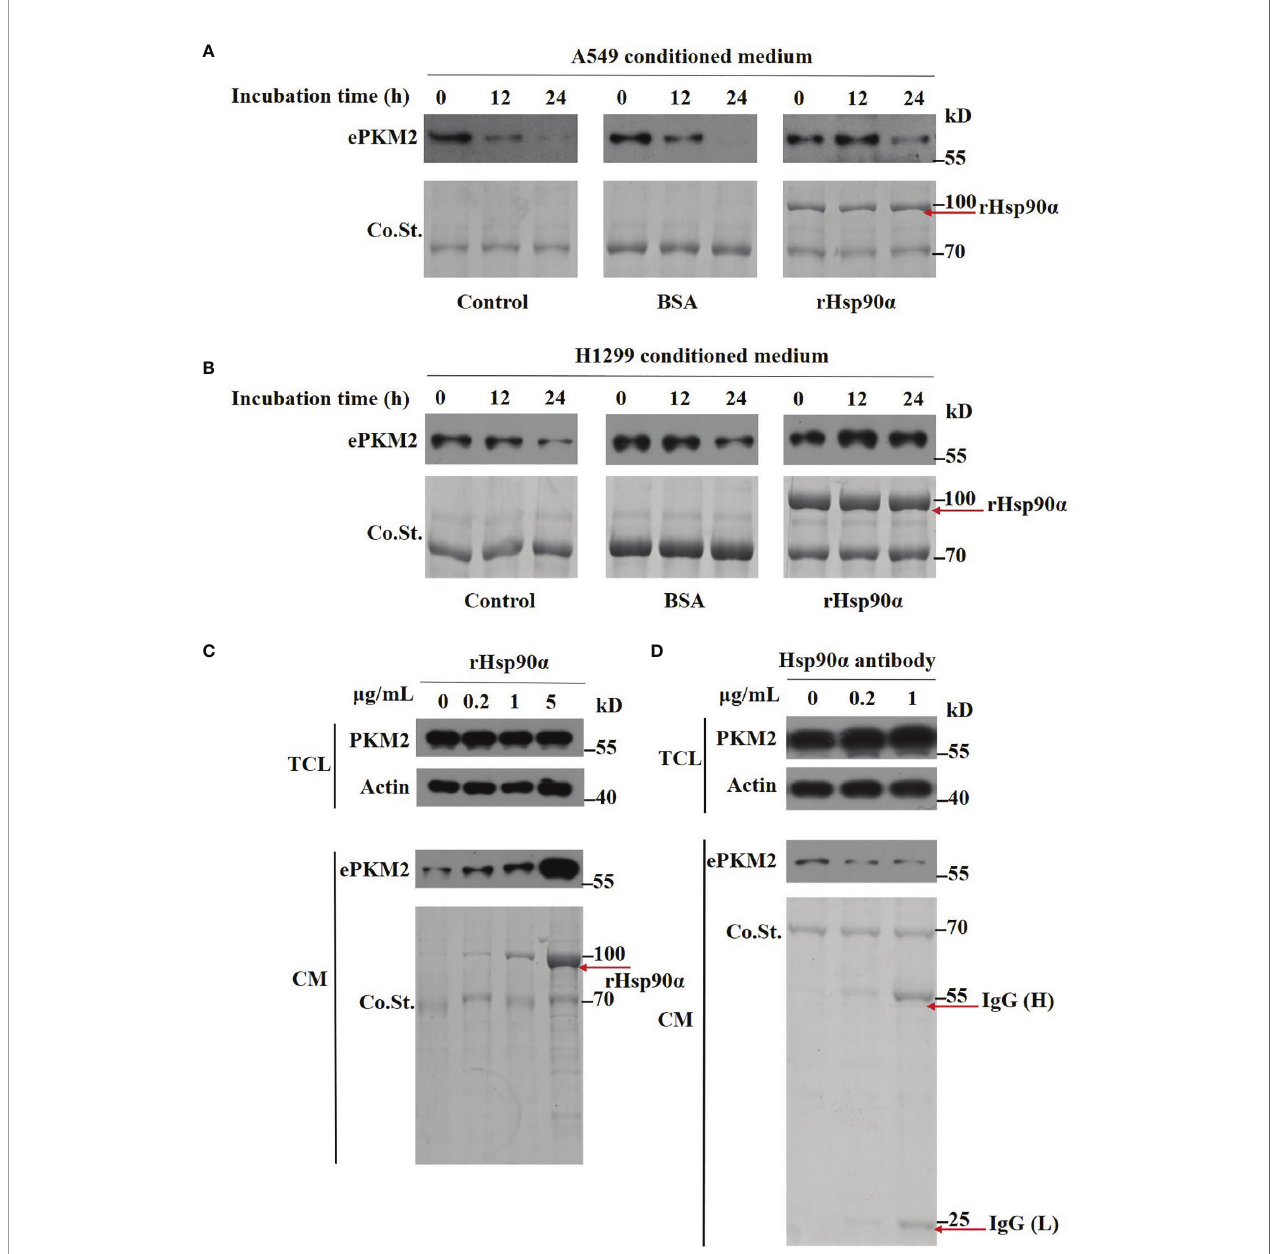
FIGURE 5 | Extracellular Hsp90 a stabilizes ePKM2. (A) The stabilization of extracellular PKM2 and Hsp90 a in A549-conditioned media. PKM2 in A549 CM was examined upon the treatment of BSA or rHsp90 a (1 m g/ml) for 12 and 24 h by Western blotting. (B) The stabilization of extracellular PKM2 and Hsp90 a in H1299- conditioned media. PKM2 in H1299 CM was examined upon the treatment of BSA or rHsp90 a (1 m g/ml) for 12 and 24 h by Western blotting. (C) Intracellular and extracellular PKM2 in A549 cells were examined upon the treatment of rHsp90 a with different concentrations on cells for 12 h by Western blotting. (D) Intracellular and extracellular PKM2 in A549 cells were examined upon the treatment of Hsp90 a antibody with different concentrations on cells for 12 h by Western